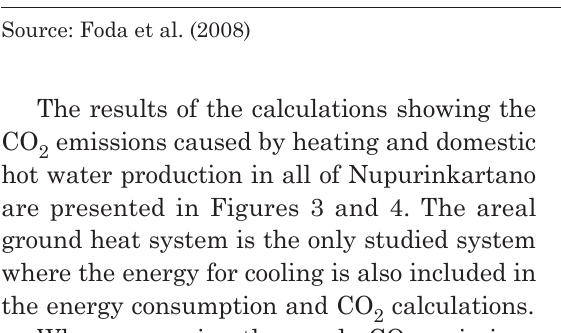
table 5. Energy use in Nupurinkartano Nupurinkartano energy use (domestic hot